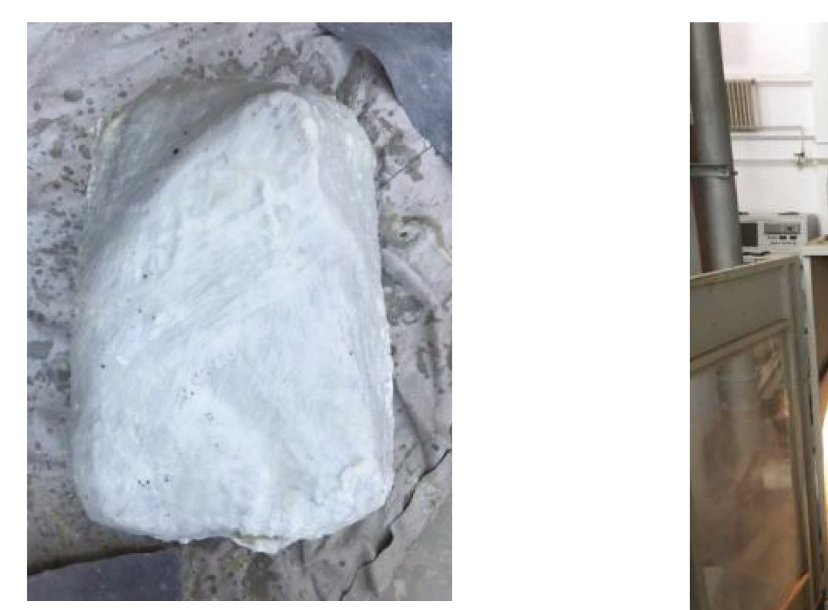
Figure 1: Sealing and preservation of the rock block with wax.